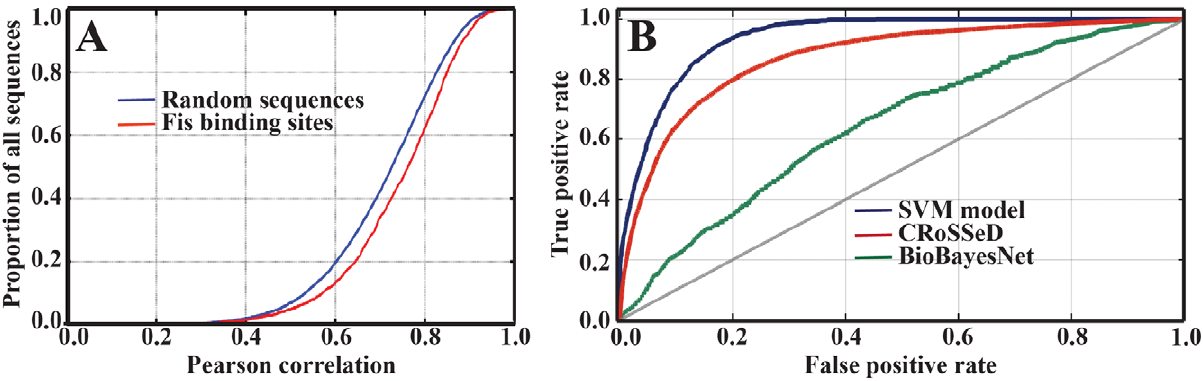
Figure 4. Fis i nvivo binding sites vs. randomly selected E. coli genomic sequences. (A) Cumulative density functions of subsequences with most significant correlation with COP. The Fis binding sites dataset is shown as a red curve while the random sequences dataset is depicted as a blue curve. The x-axis is the Pearson correlation coefficient while the y-axis is the proportion of subsequences with a maximum correlation with the COP profile worst or equal to the corresponding x value. (B) Receiver-operating curves base on our SVM model as well as models built with CRoSSeD and BioBayesNet. The x-axis depicts the false positive rate while the y-axis depicts true positive predictions. The blue curve corresponds to the results from our SVM classifier, the red curve to ones from the CRoSSeD model, and the green curve to ones from the BioBayesNet model.